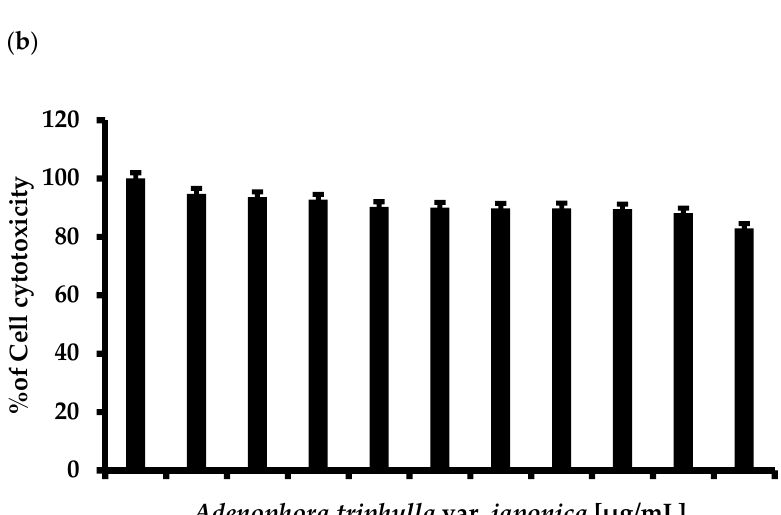
Figure 6. Effects of A. triphylla var. japonica extract on the cell viability in HaCaT cells and THP-1 cells. ( a ) HaCaT cells and ( b ) THP-1 cells were treated with the indicated concentration of A. triphylla var. japonica extract for 24 h. The cell viability was evaluated by MTT assay. Experiments were performed in triplicate.